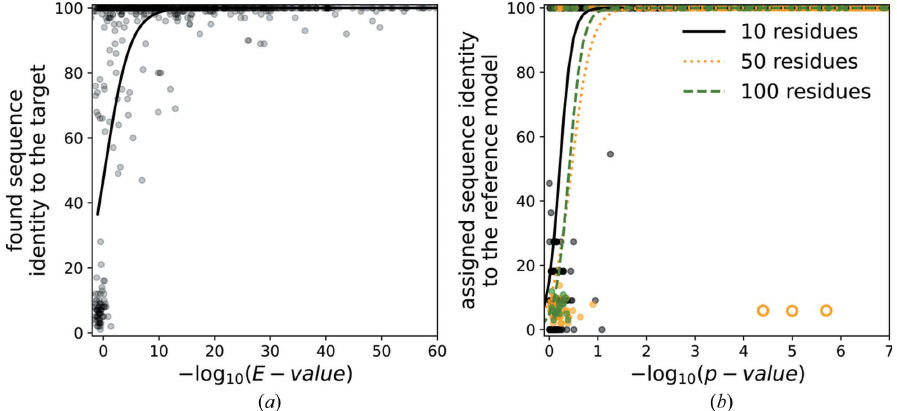
Figure 4 Sequence-identification and assignment benchmarks for EM models. ( a ) Identity of a sequence identified for models built de novo using ARP/wARP as a function of HMMsearch best-single-domain sequence-alignment score. ( b ) Identity of a sequence assigned to continuous fragments of deposited EM models as a function of the sequence-assignment score ( p value) for protein-fragment lengths of 10, 50 and 100 residues selected at random from test-set models. The continuous curves on the plots are logistic regression estimates of a probability that an identified sequence will have at least 80% sequence identity to the reference model. The orange circles represent three reference chains with register error that were not used for the logistic regression calculations.